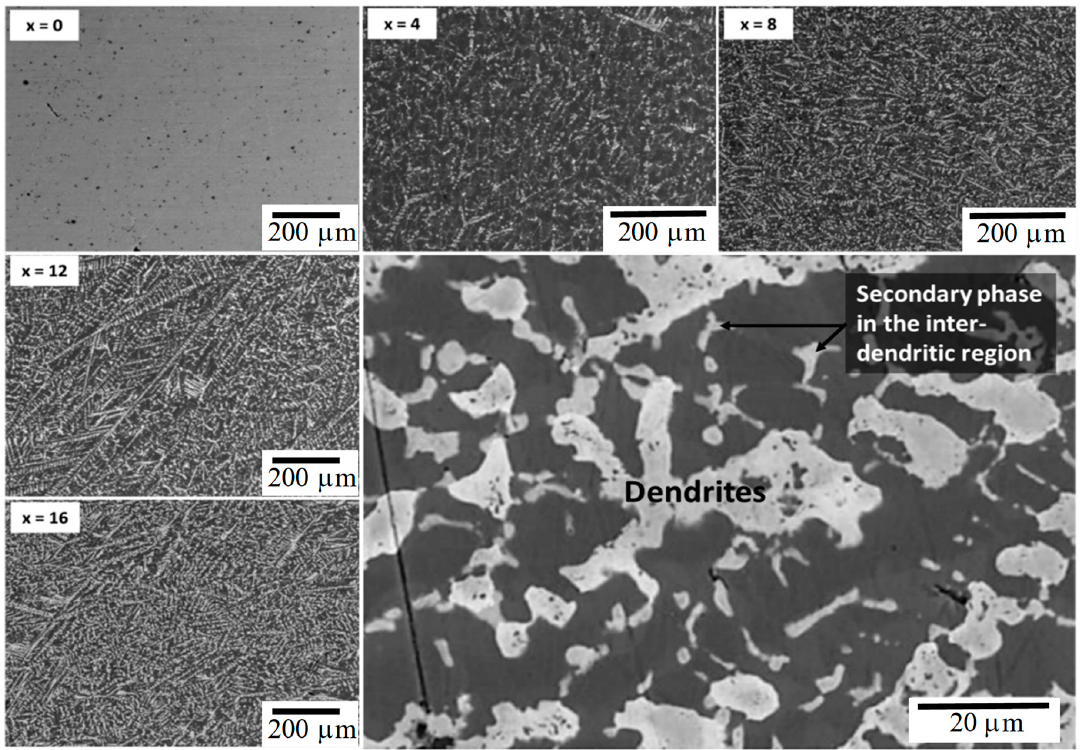
Figure 2. SEM (Scanning Electron Microscopy) images in backscattered (BSE) mode of the as-cast TiFe + x Hf alloys (with x = 0, 4, 8, 12, and 16 wt.%), and a higher magnification image of the TiFe + 16 wt.% Hf alloy. Table 2. Compositions (in at.%) of the three phases in TiFe + x Hf alloys (with x = 4, 8 and 12, and 16 wt.% of Hf) after solidification. Experimental